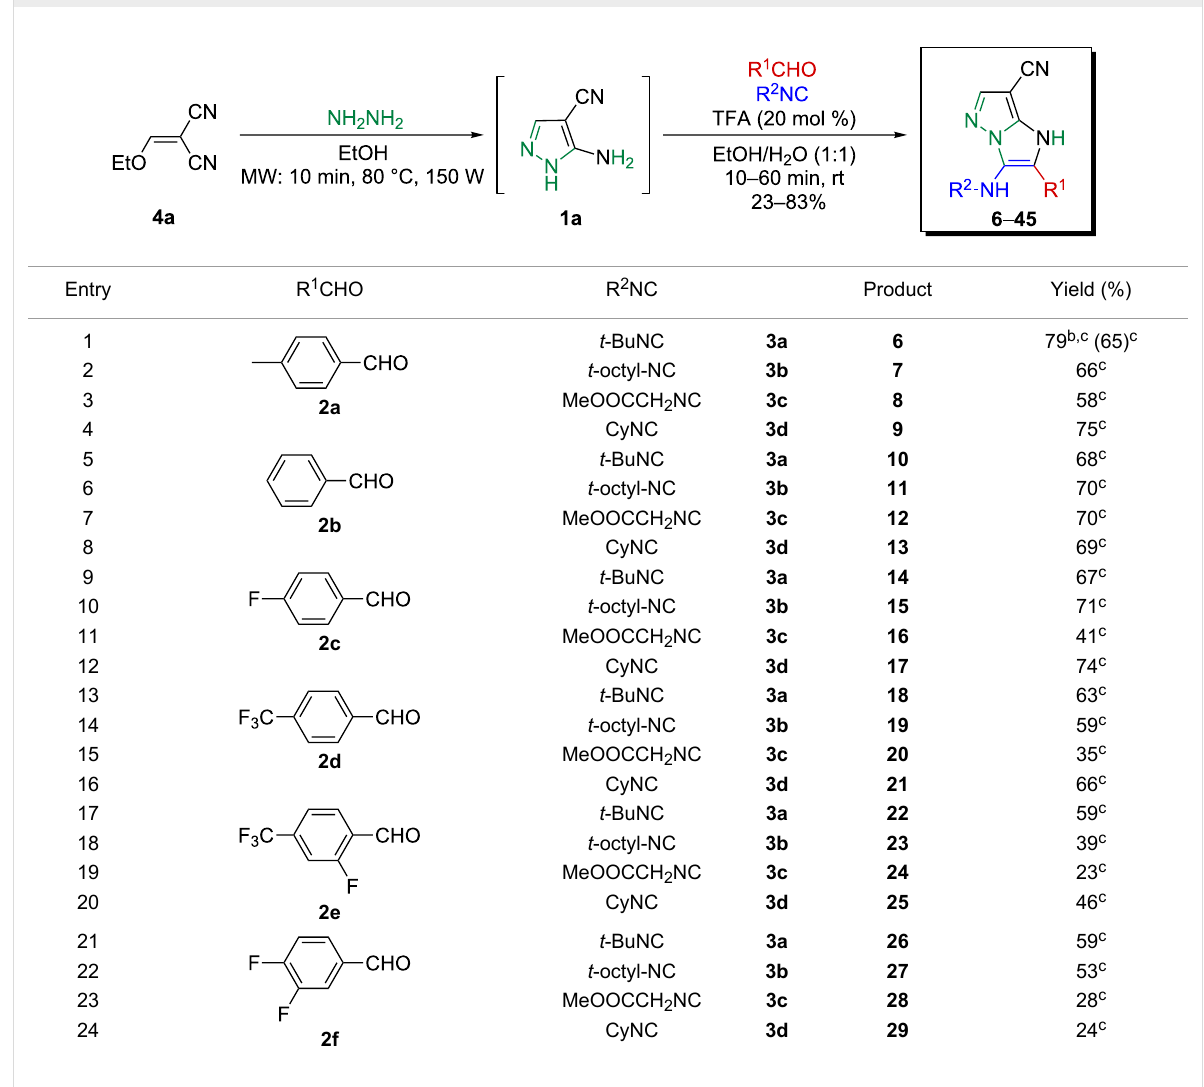
Table 2: Sequential one-pot GBB library generation a